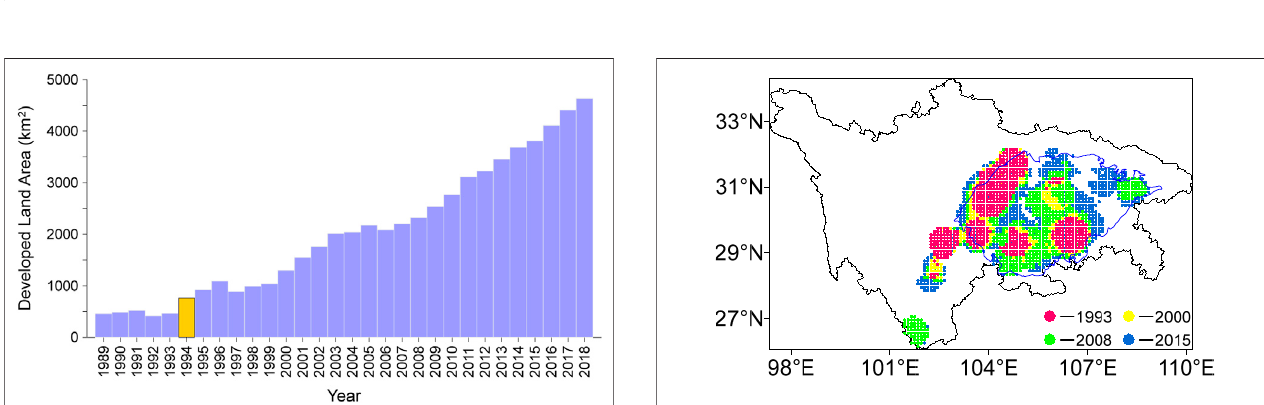
Frontiers in Earth Science |